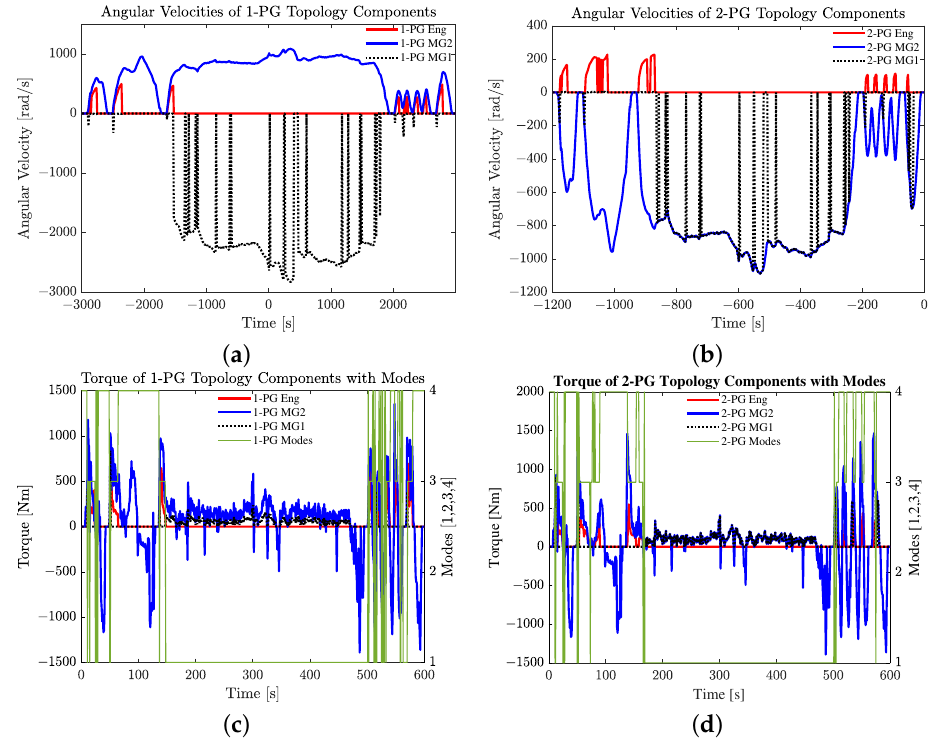
Figure 5. Simulation results for ( a ) Angular velocities of each component at each mode for 1-PG topology, ( b ) Angular velocities of each component at each mode for 2-PG topology, ( c ) Torque distribution at each mode for 1-PG topology, ( d ) Torque distribution at each mode for 2-PG